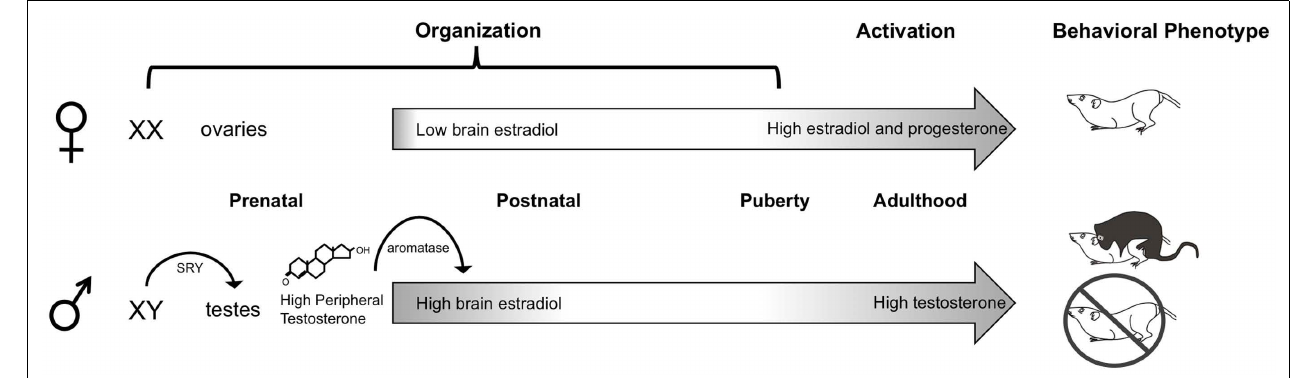
enzyme into estradiol, which acts to masculinize and defeminize the brain. A second organizational period occurs peripubertally, when steroid hormones begin to rise. In adulthood, the differentiated brain is activated by high levels of circulating gonadal hormones: androgens in males and estrogens and progestins in females, to produce sex differences in copulatory